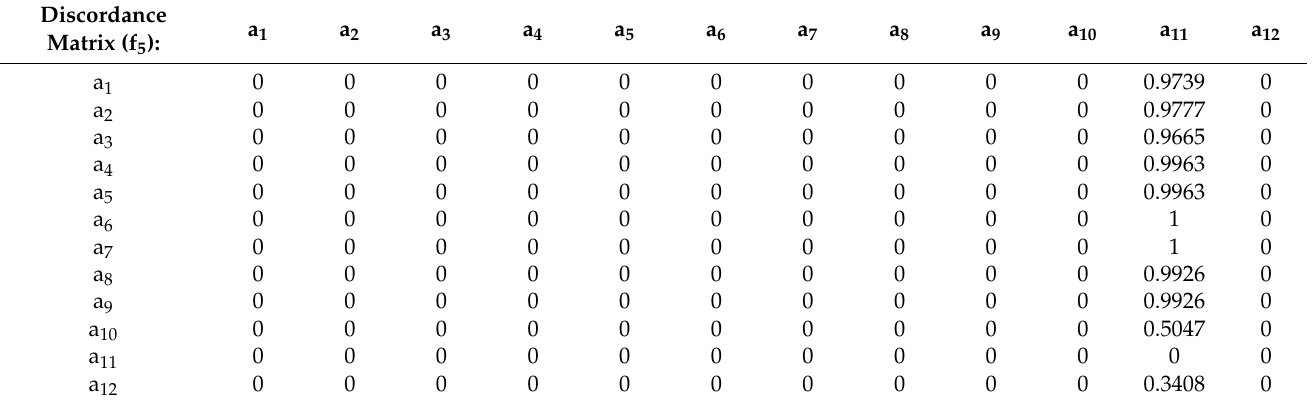
Table A5. Values of the non-compliance indicators according to the 5th criterion.